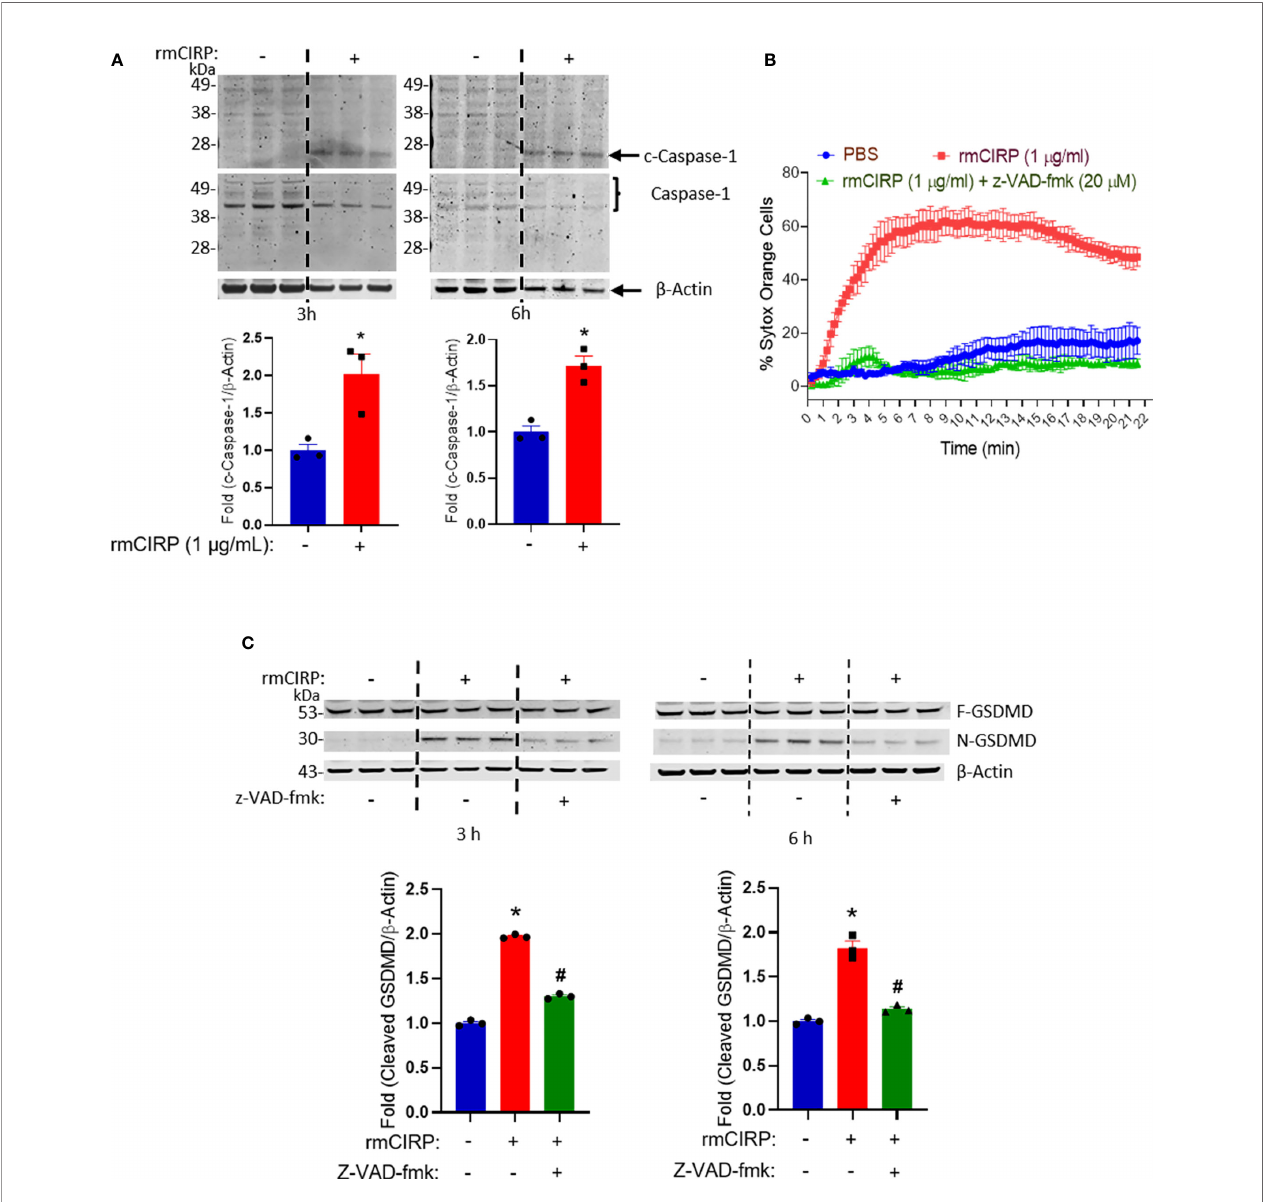
FIGURE 6 | Caspase-1 regulates eCIRP-induced GSDMD-mediated MET formation in THP-1 cells. (A) Caspase-1 is cleaved by the treatment of rmCIRP (1 µg/ml) in THP-1 cells. The cleavage of caspase-1 was observed at 3 and 6 h after the treatment of rmCIRP (1 µg/ml). The Western blot of cleaved caspase-1 was detected fi rst. Full-length GSDMD and b -actin were probed at the same time after stripping the anti-cleaved GSDMD antibody. The intensity of bands detected was quanti fi ed by densitometry. Student t -test: *p <0.05 vs. PBS (without rmCIRP) at 3 h, *p <0.01 vs. PBS (without rmCIRP) at 6 h. (B) The effect of rmCIRP (1 µg/ml) in THP-1 cells is signi fi cantly inhibited by z-VAD-fmk (20 µM), a pan-caspase inhibitor. The inhibitor was pre-treated 30 min before rmCIRP (1 µg/ml) treatment, and the cells were subjected to the time-lapse live-cell imaging immediately after the treatment of rmCIRP. The effect of z-VAD-fmk was quanti fi ed by counting the cells positive to SYTOX Orange. (C) Treatment of z-VAD-fmk at a dose of 20 µM inhibits the activation of GSDMD by rmCIRP (1 µg/ml). The western blot of cleaved GSDMD was done fi rst. Full length GSDMD and b -actin were probed at the same time after stripping off the anti-cleaved GSDMD antibody. The band intensity was determined by densitometry and compared to the control group. Full gel images are shown in Supplementary Figure S4 . One-way ANOVA with Turkey method: *p < 0.01 vs. PBS; # p < 0.01 vs. mCIRP for 3 or 6 h treatment